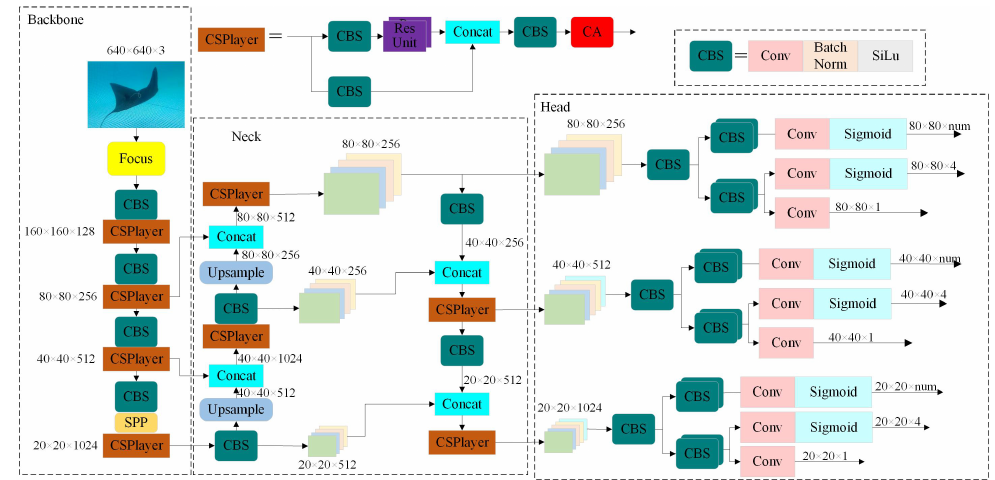
Figure 7. Network structure diagram of the improved YOLOx.